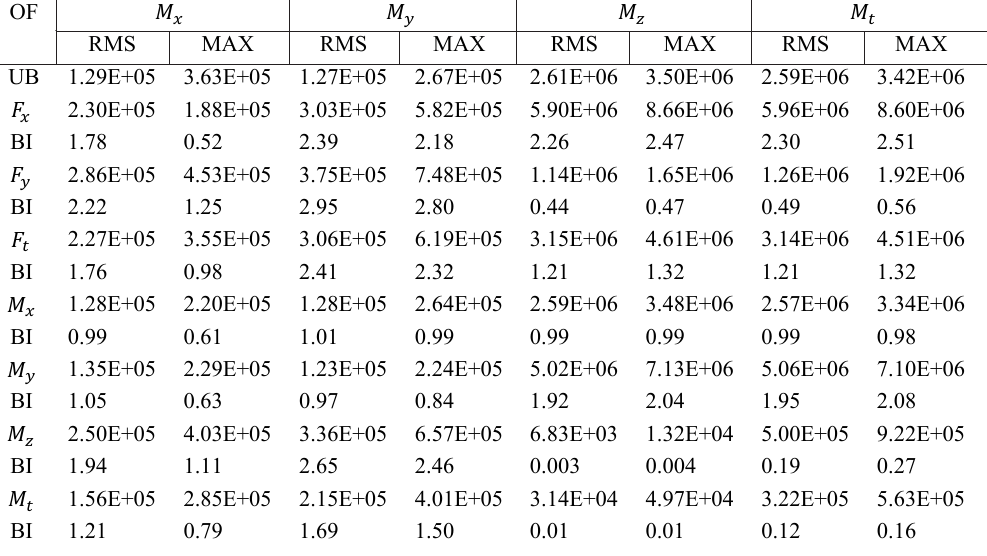
Table 2. RMS, MAX, and BI results of shaking moment